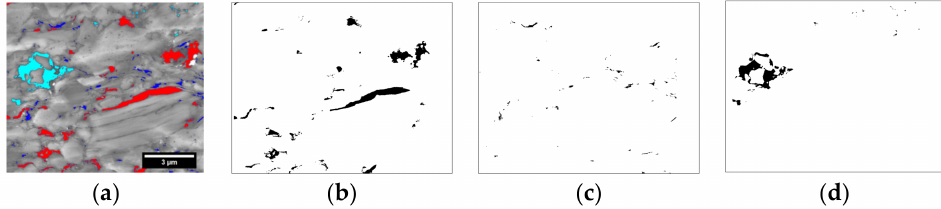
Figure 1. Pore identification and extraction: ( a ) Pore identification; ( b ) Extraction of interparticle pores; ( c ) Extraction of clay mineral intraparticle pores; ( d ) Extraction of dissolution